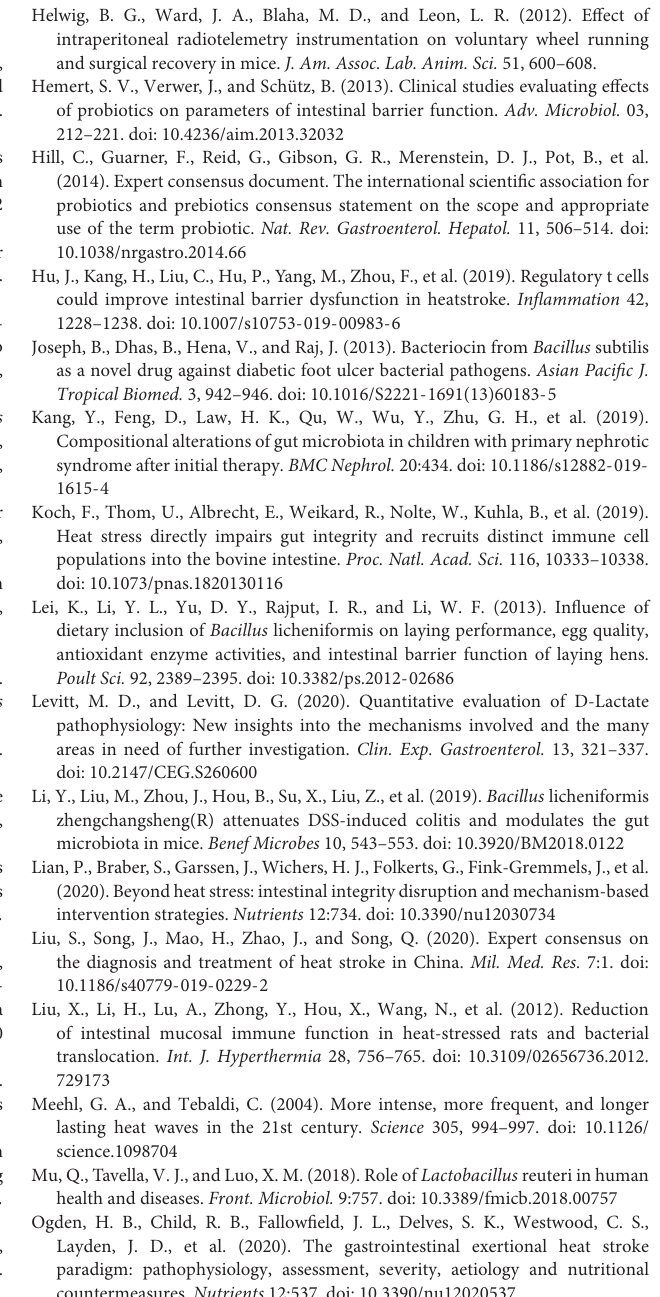
Supplementary Figure 4 | Summary of HS pathophysiological alterations that lead to a cascade of events including SIRS, DIC, MODS, and even death. Intestinal injury caused by HS-induced visceral ischemia plays a key role in HS pathogenesis and pathophysiology. Intestinal injury, which is comprised of enterocyte death and tight junction disintegration, results in intestinal barrier dysfunction and triggers gut-derived endotoxemia, which activates subsequent systemic inflammatory response and multiple organ